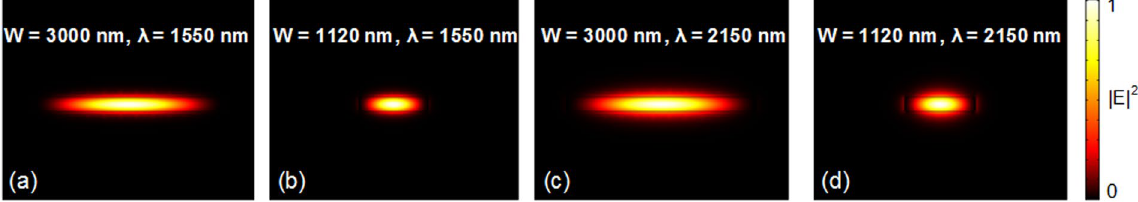
Figure 3. Optical field distributions at ( a ) input port with W = 3000 nm and λ = 1550 nm, ( b ) output port with W = 1120 nm and λ = 1550 nm, ( c ) input port with W = 3000 nm and λ = 2150 nm, and ( d ) output port with W = 1120 nm and λ = 2150 nm.